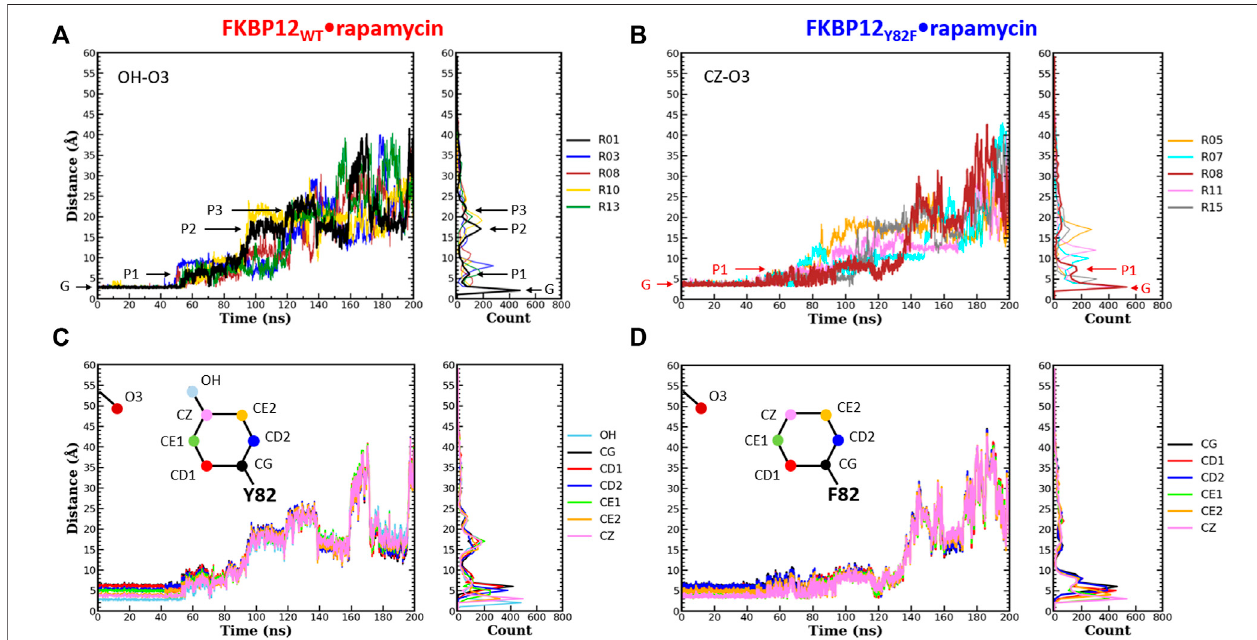
FIGURE 3| Comparison of the separation distance patterns obtained during the dissociation ofrapamycin from the wild-type FKBP12 and from the Y82F mutant. PullingonthemolecularpartnersCoGstartsat10ns. (A) EvolutionofthedistancebetweentheO3carbonyloxygenofrapamycinandtheOHhydroxyloxygenofresidue (cid:129) Y82 in the FKBP12 WT rapamycin complex. For the sake of clarity, data are only provided for the R01 lower-bound PMF pro fi le and for four other ones. The G and Pi markersindicate,forthetime-traceandthehistogramassociatedwiththelower-boundpro fi le,thegroundleveland thedifferentplateaus,respectively.Theresults for all 15 CPUS simulations are displayed in Supplementary Figures S9A . (B) Same plot for the distance between the O3 carbonyl oxygen of rapamycin and the CZ (cid:129) most distal carbon of residue F82 in the FKBP12 Y82F rapamycin complex. The lower-bound PMF pro fi le is now R08, and the data for all 15 CPUS simulations are available in Supplementary Figures S9B . (C) Evolution of the distance between the O3 carbonyl oxygen of rapamycin and the seven heavy atoms of residue Y82 (cid:129) phenolgroupintheFKBP12 WT rapamycincomplex.Thedataareonlyprovidedforthelower-boundPMFpro fi le(see SupplementaryFiguresS9A forthewholesetof curves). (D) Same plot for the distance between the O3 carbonyl oxygen of rapamycin and the six carbons of the residue F82 phenyl group in the (cid:129) FKBP12 Y82F rapamycincomplex.Oncemoredataareonlyprovidedforthelower-boundPMFpro fi le,see SupplementaryFiguresS9B foranexhaustivepresentation of the